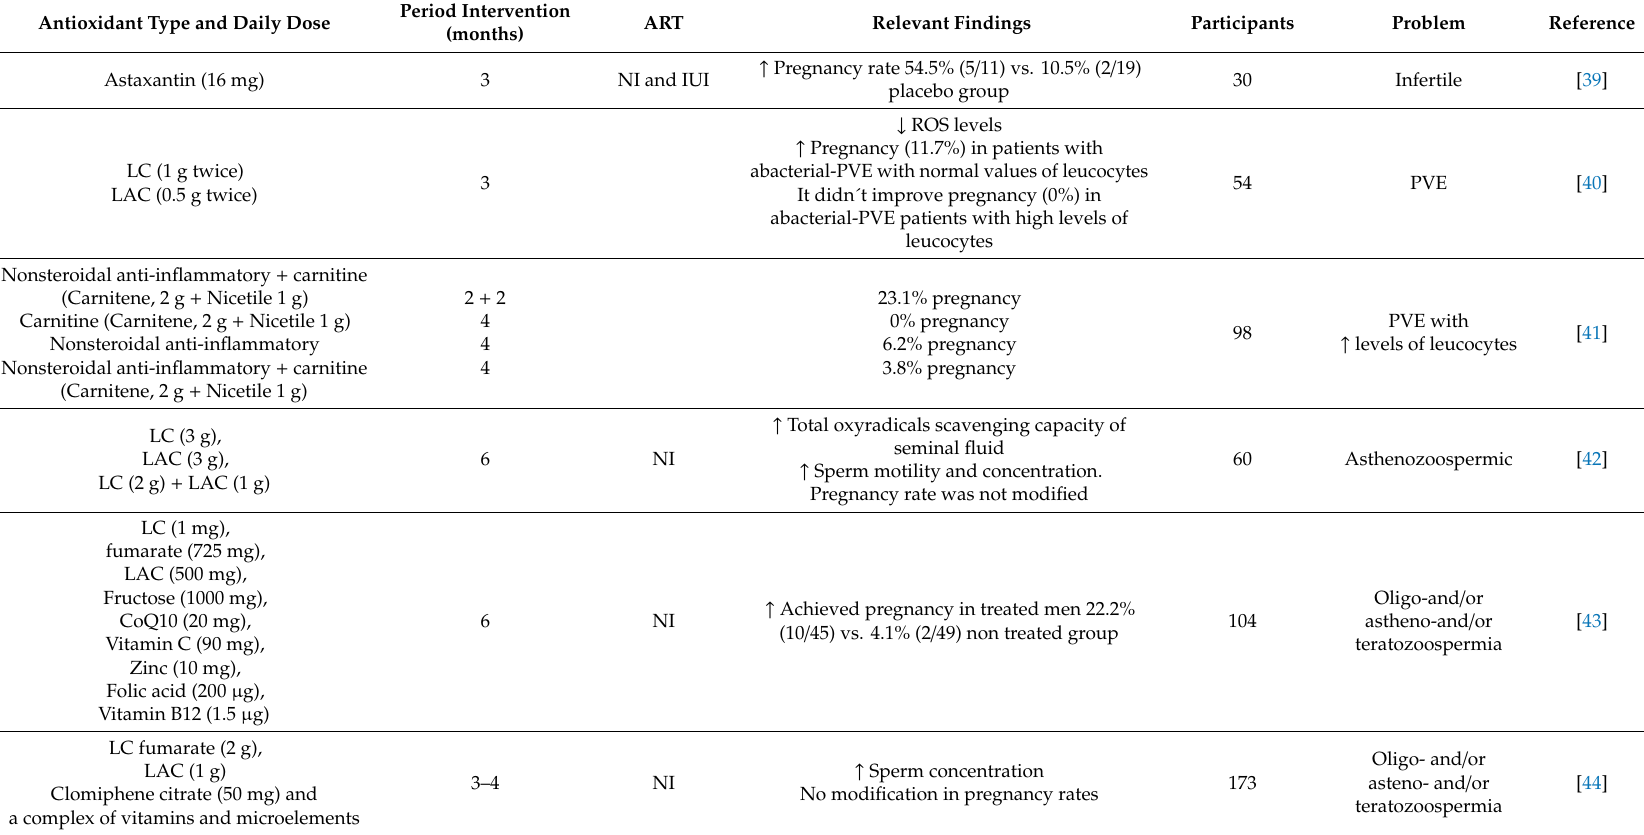
Table 1. E ff ects of oral antioxidant intake on infertile men’s reproductive